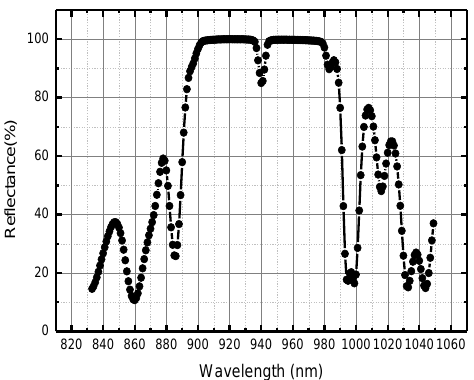
Figure 8. Measured results of the reflectance of a VCSEL (vertical cavity surface emitting laser) structure as functions of wavelength.